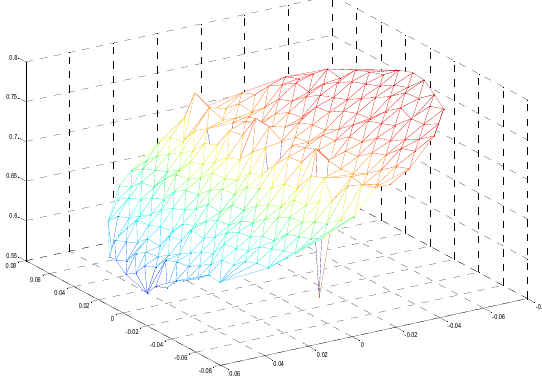
Figure 5. The point cloud. The red points are in the circular window. The left figure shows the point set P sori . The right figure shows the point set P gori . X,Y,Z-axis represent rsin θ cos ϕ , rsin θ sin ϕ , rcos θ .